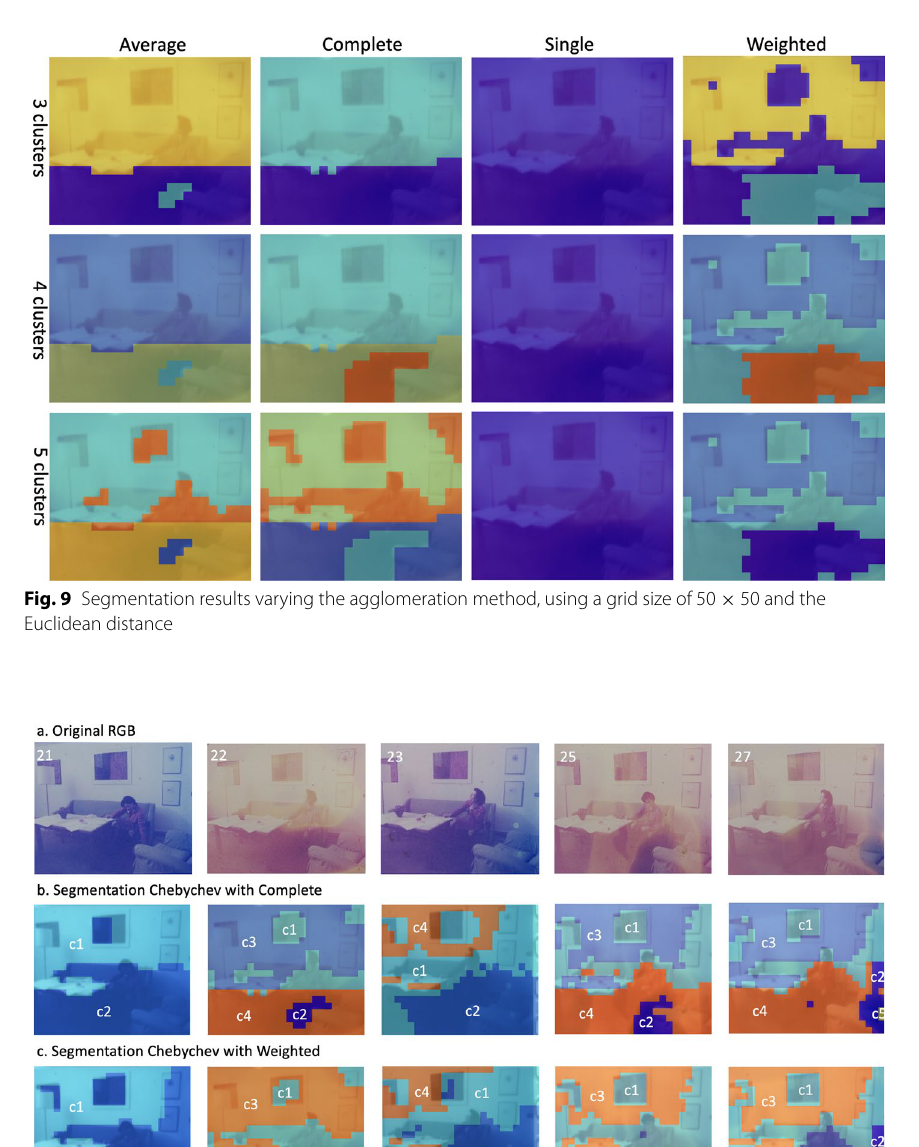
Fig. 10 Segmentation results on the full dataset (images 21, 22, 23, 25, and 27): a the original RGB images. b results obtained using the Chebyshev metric and the complete method. c results obtained using